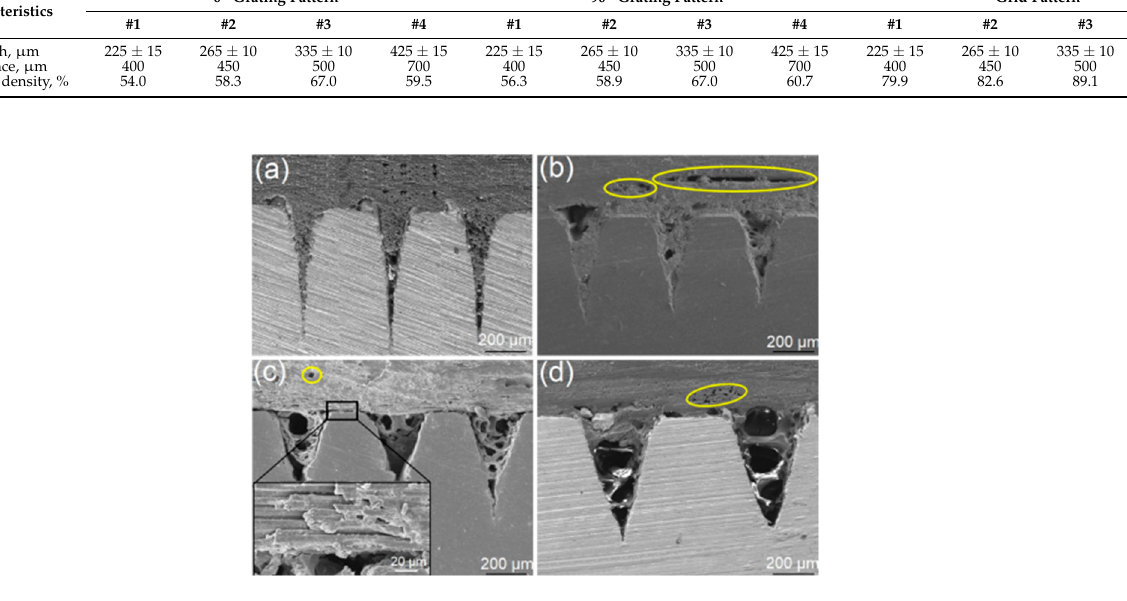
Figure 4. Cross-sectional morphologies of laser joining-produced CCF30/PEEK-Ti6Al4V joints in case of the 0° grating textures with microgrooves width of 225 ± 15 μ m ( a ), 265 ± 10 μ m ( b ), 335 ± 10 μ m ( c ), and 425 ± 15 μ m ( d ), respectively.